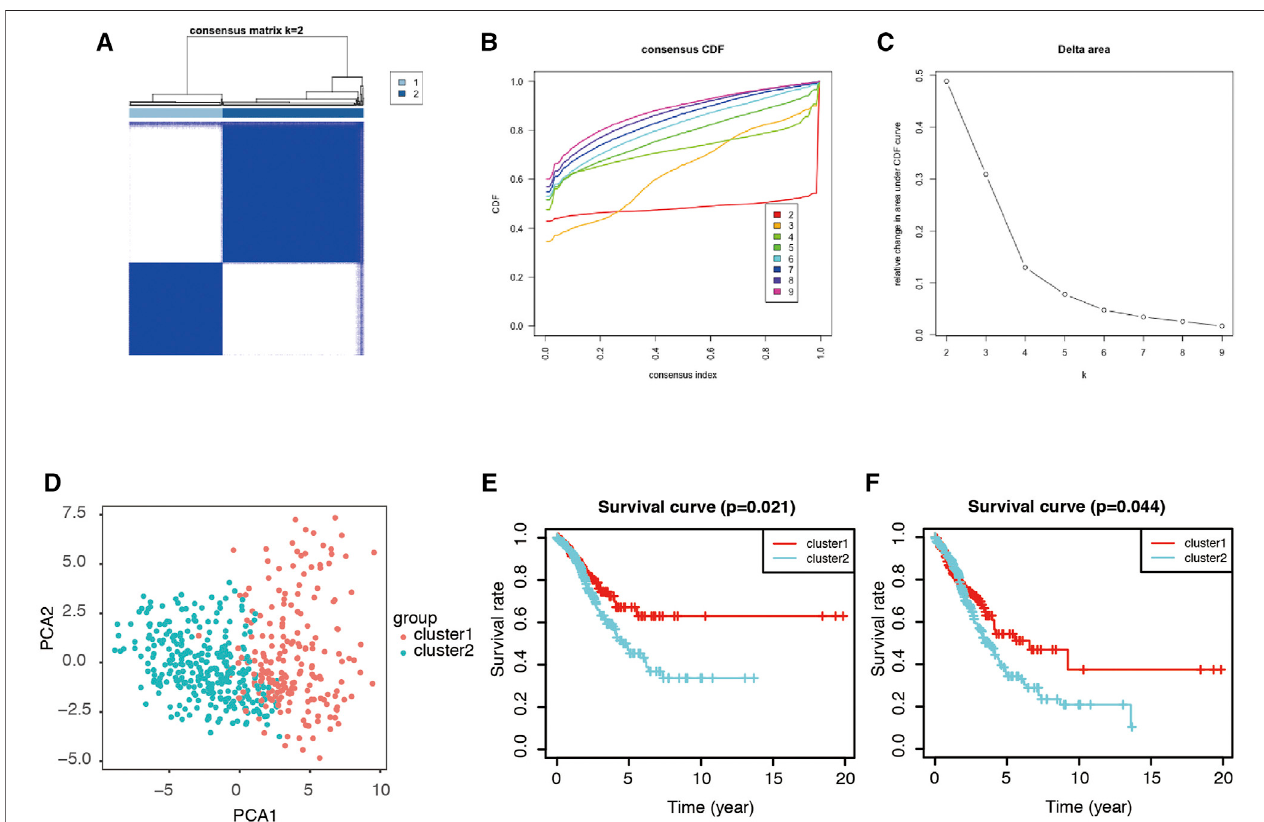
FIGURE5| PCAanalysisofgenesinturquoisemodule. (A) Consensusmatrixoftwosubgroups(k=2). (B,C) Selectionofkvalue.Consensusclusteringcumulative distribution function (CDF) was set from k = 2 to 9. (D) Principal component analysis of the total RNA expression pro fi le. (E) Kaplan-Meier overall survival (OS) curve for LUAD patients in cluster 1 and cluster 2. (F) Kaplan-Meier recurrence-free survival (RFS) curve for LUAD patients in cluster 1 and cluster 2.